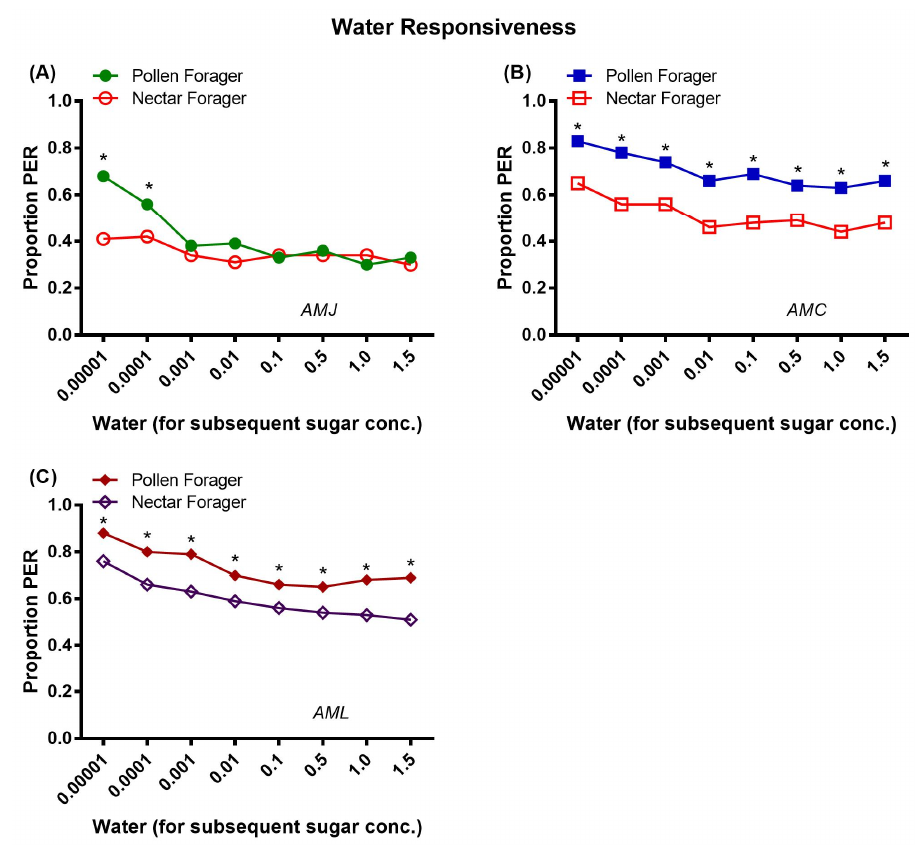
Figure 8. Water responsiveness, i.e., response of pollen and nectar foragers of a single honey bee subspecies AMJ ( A ), AMC ( B ) and AML ( C ) to water tested prior to the PER test to each sugar concentration during the fall season. Asterisks indicate the significant difference ( x 2 or Fisher’s exact test * p < 0.05) between the water responses of pollen and nectar foragers of individual honey bee subspecies ( AMJ , AMC and AML ).